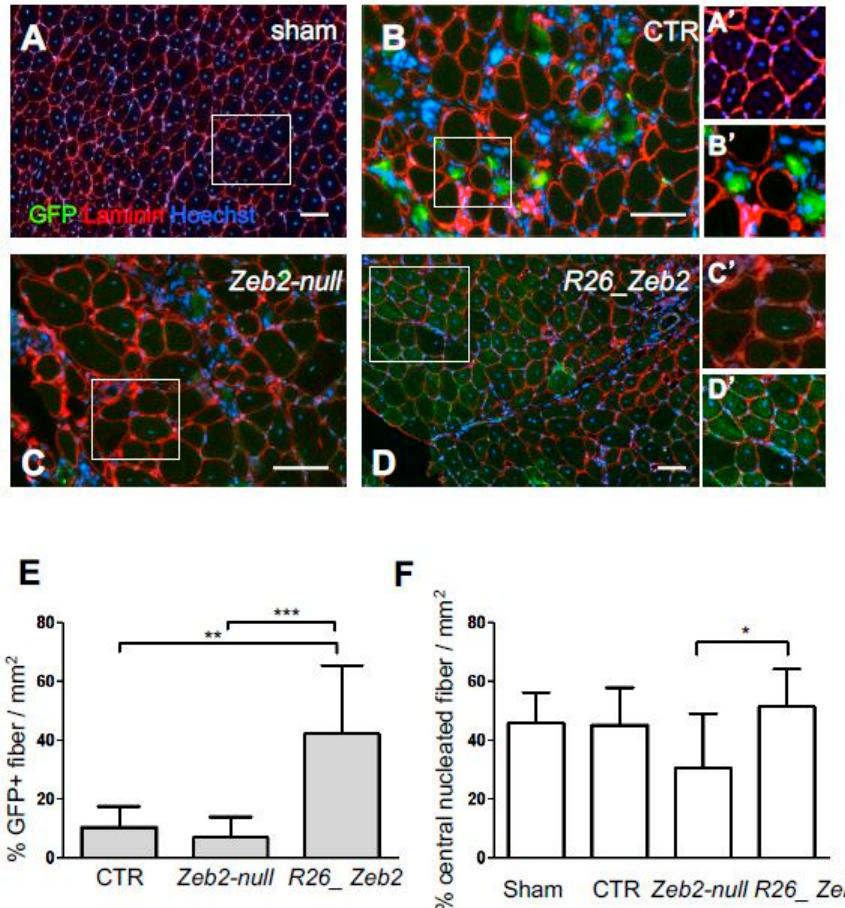
Figure 4. Intramuscular injections of Zeb2-null and R26_Zeb2 mESC derivatives in an acute muscle injury model. Immunofluorescence analysis of GFP (green) and laminin (red) in sham-operated ( A , A ’) muscles or injected with CTR ( Zeb2 flox/flox as control) ( B , B ’), Zeb2-null ( C , C ’), and R26_Zeb2 ( D , D ’) GFP + mESC derivatives. Nuclei were stained in blue with Hoechst; scale bars = 100 µm. Quantification of GFP + ( E ) and GFP + central nucleated ( F ) fibers in injected muscles and expressed as mean ± SD; n = 5 (10 randomly selected fields were examined per sample); * p < 0.05, ** p < 0.005, *** p < 0.0001.